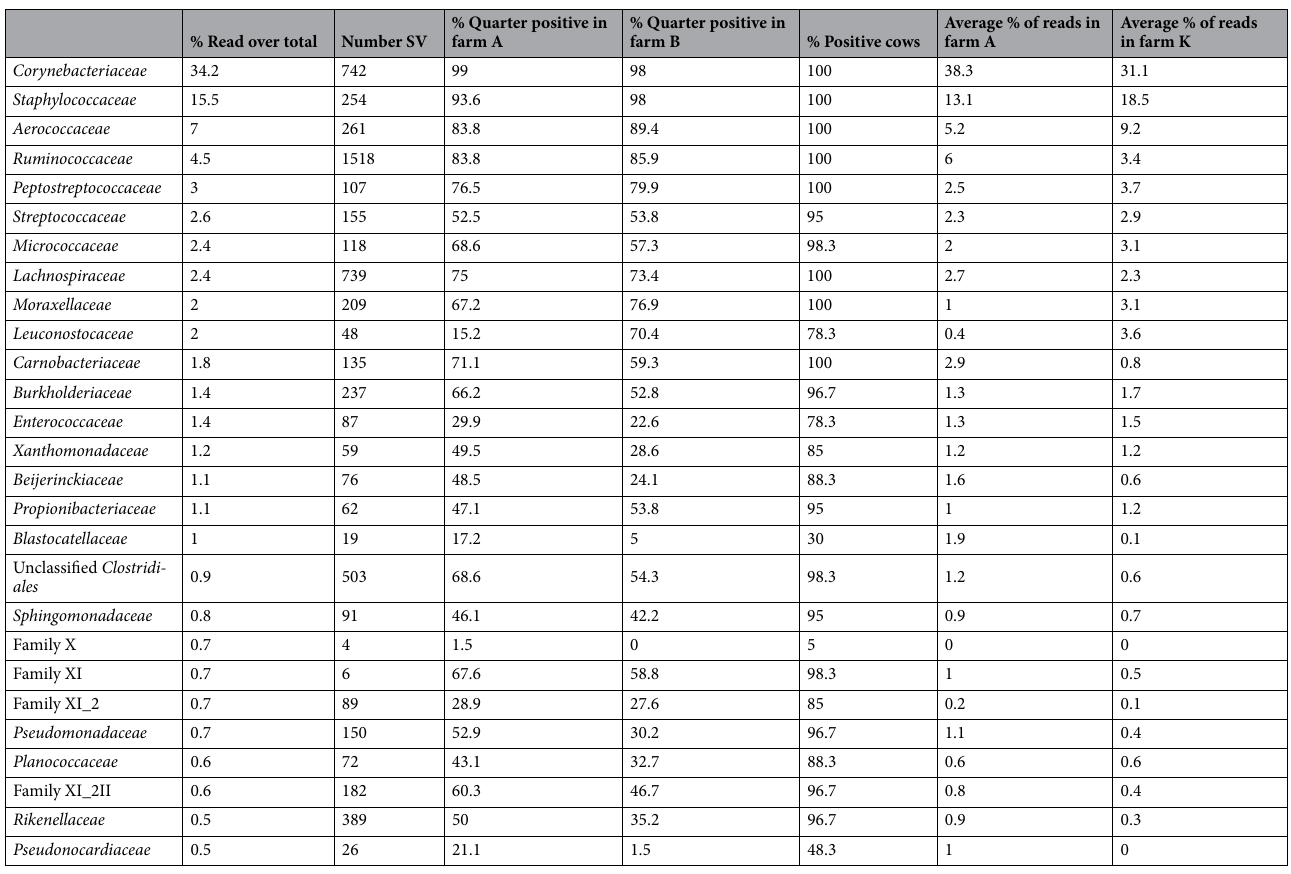
Table 1. Descriptive results of the microbiota summarized at family level (> 0.5%) detected in 403 quarter milk samples of 60 Norwegian Red